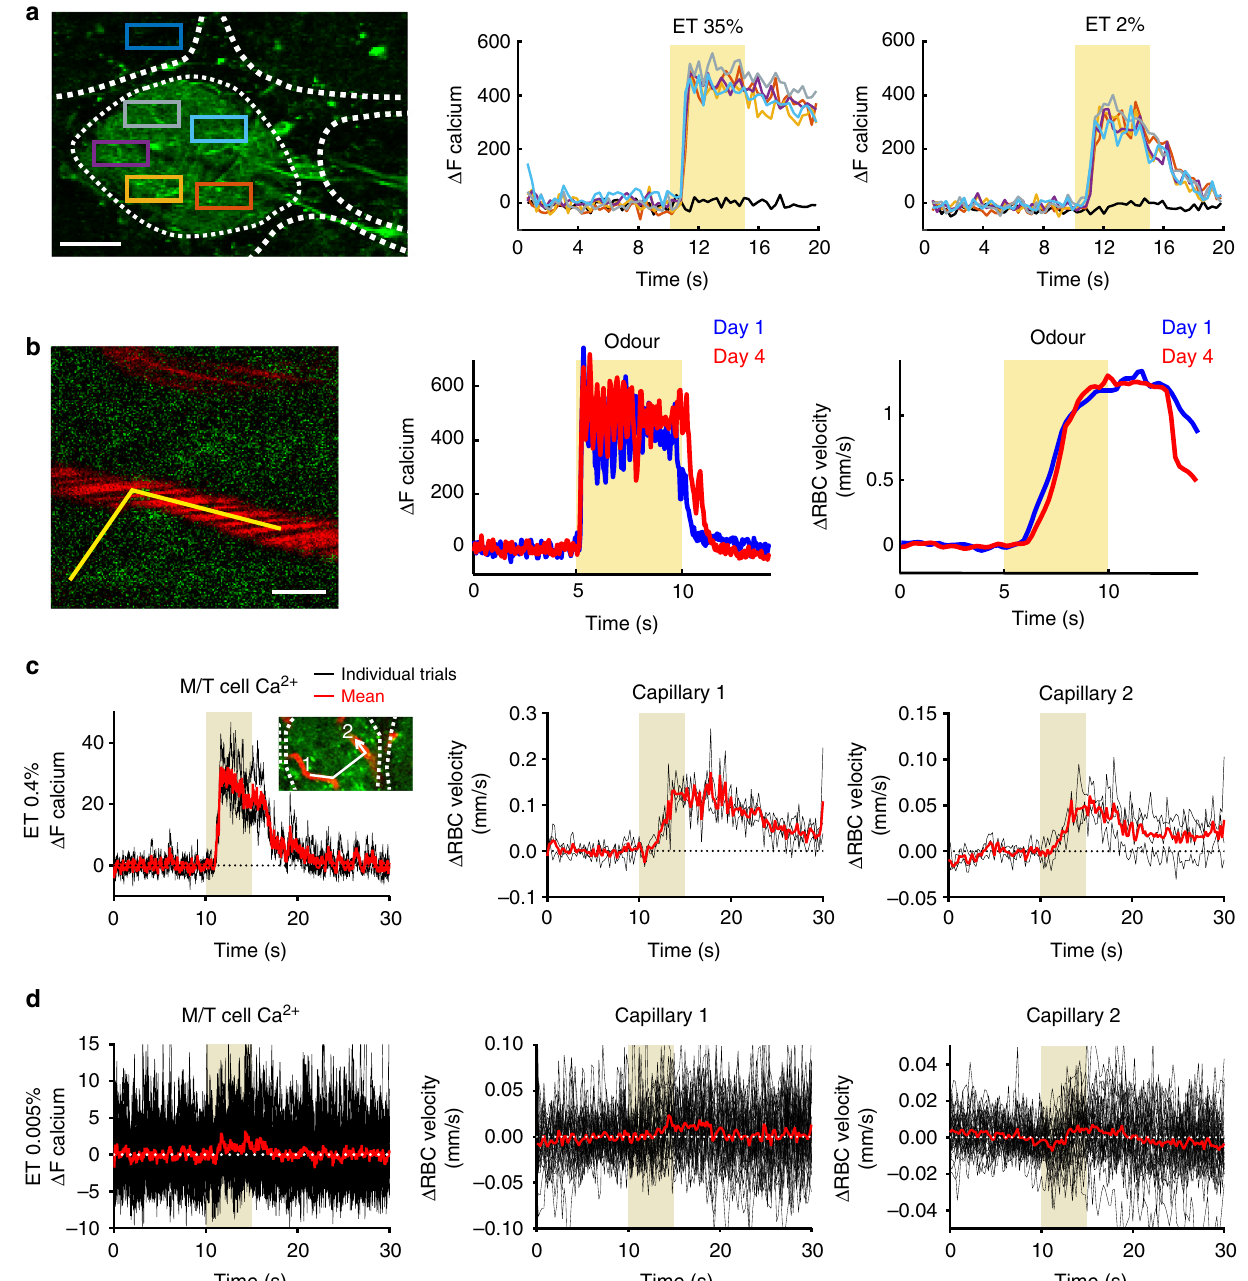
Fig. 2 Characterization of vascular responses to odour in mice implanted with a chronic PMP window. Mice expressing GCaMP6f under the Thy1 promoter were imaged with TPLSM. a Odour causes a homogenous elevation of Ca 2 + in mitral cell dendrites throughout the glomerulus. Left: Ca 2 + was monitored in fi ve ROIs located in the activated glomerulus and in one ROI located outside (black trace) (scale bar: 30 µ m). Middle: Δ Ca 2 + dynamics and magnitude measured in all fi ve ROIs comprised within the glomerulus were similar upon inhalation of ET (35%). Fluorescence did not change outside the glomerulus. Right: Ca 2 + responses to 2% ET were smaller but similarly homogenous in the glomerulus. b Left: a broken line (in yellow) was used in the linescan acquisition mode to monitor Ca 2 + in the neuropil and RBC velocity in a capillary (scale bar: 5 µ m). Odour reproducibly causes a large Ca 2 + increase the neuropil (middle), followed by an increase in RBC velocity (right). Both responses are very similar on day 1 and day 4 (averages of two inhalations). c , d Neuronal and RBC velocity responses remain coupled at 0.4% and 0.005% ET odour concentration. c Left: three single trials (black traces) and average (red trace) Ca 2 + responses of the linescan segment between the two capillary segments (inset). Middle and right: corresponding RBC velocity responses in capillary 1 and 2, respectively. d Neuronal and RBC velocity responses persist at minimal odour stimulation threshold (ET 0.005%). Same as ( c ), except 30 individual trials (black) were averaged (red), as the single trial Ca 2 + and RBC velocity responses were both hidden within the resting fl uctuations. Baseline RBC velocities: b 0.35 mm/s; c and d 0.15 and 0.13